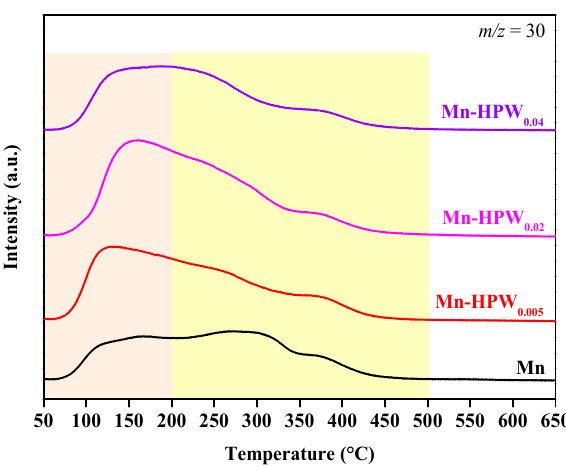
adsorption capacity.